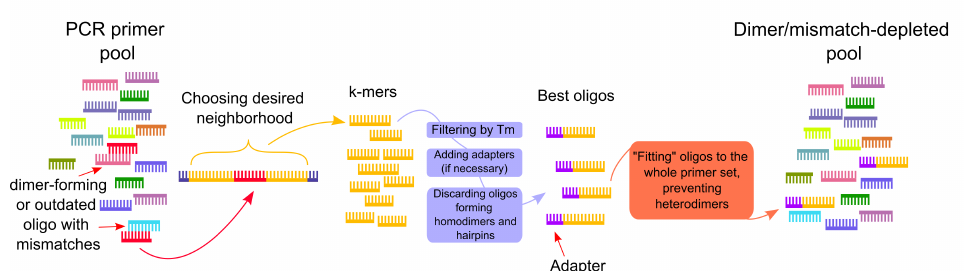
Figure 2. Schematic diagram of the pipeline for updating primer